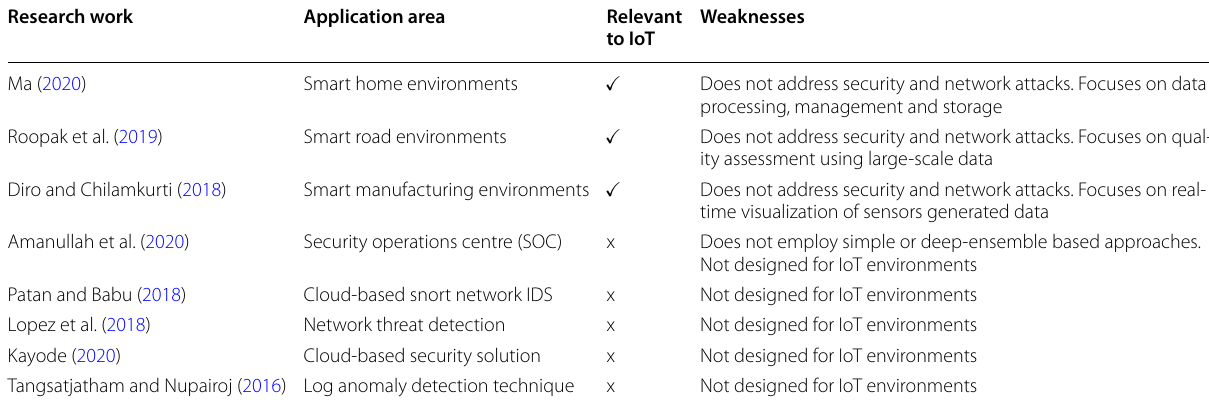
Table 3 Using Lambda architecture to address big data issues Research